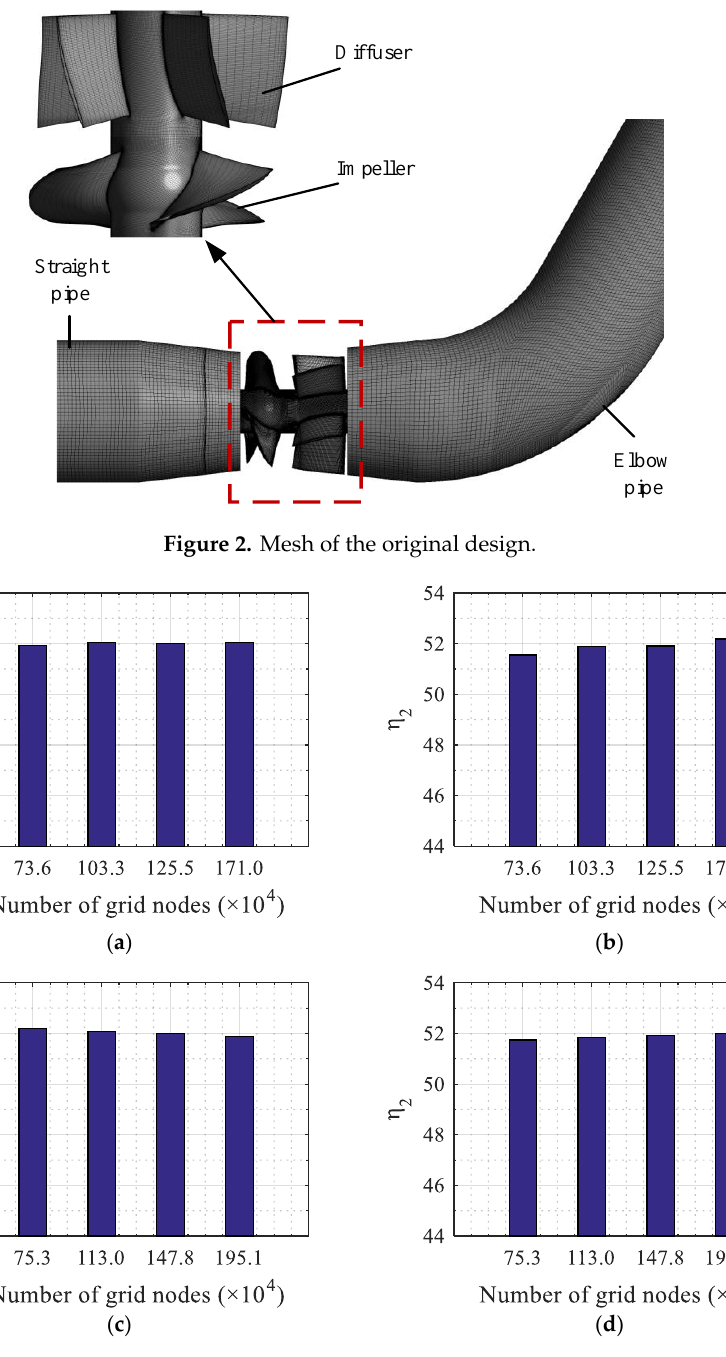
Figure 3. Grid independence of the original design for the ( a ) impeller under a forward design flowrate, ( b ) impeller under a reverse design flow rate, ( c ) di ff user under a forward design flowrate and ( d ) di ff user under a reverse design flow